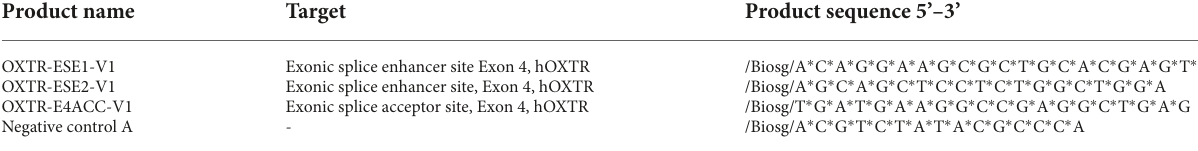
TABLE 2 Sequence and binding site of OXTR specific Gapmers and negative control (referred to as n.c. in the figures)